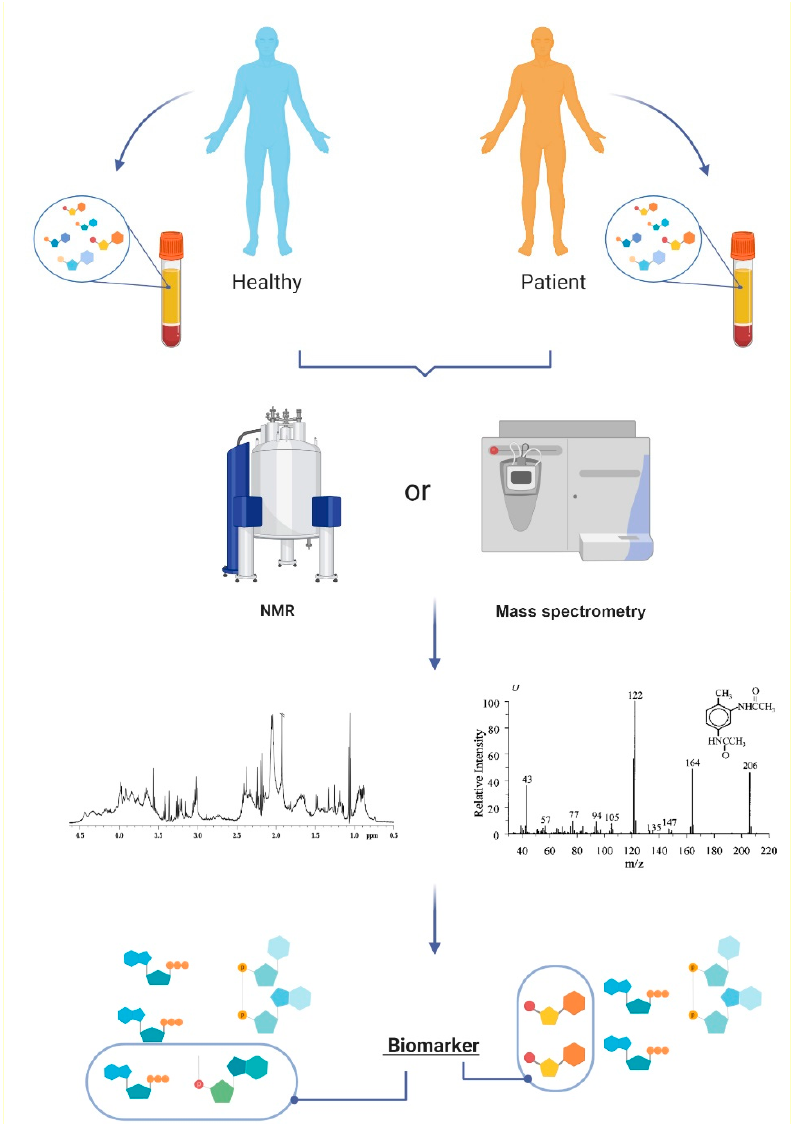
Figure 2. Metabolomic scheme for identifying biomarkers . Circulating metabolites are found in biofluids and may be used as disease biomarkers. Metabolomics can be applied to identify metabolites using high-throughput techniques, such as mass spectrometry or nuclear magnetic resonance (NMR). By processing and analyzing the data from metabolomics studies, one can identify specific metabolites as disease biomarkers. This figure was created with Biorender.com.